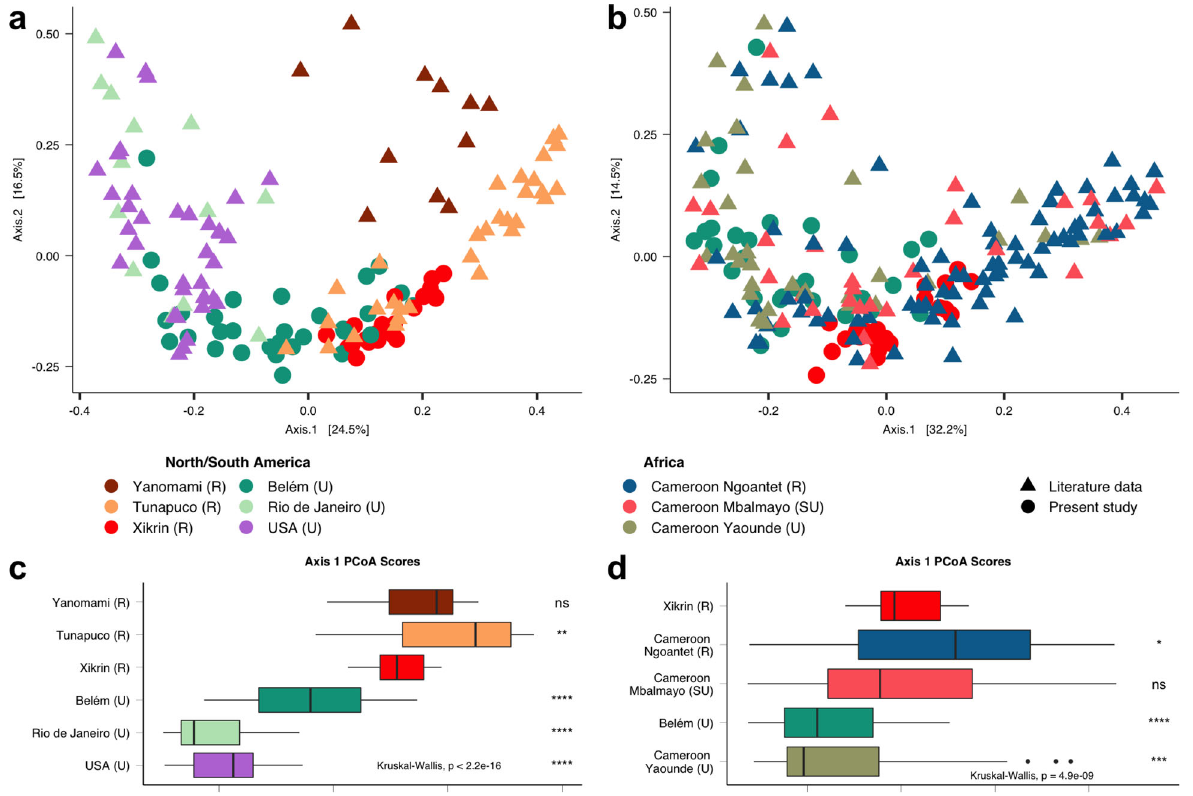
Fig. 5 PCoA of Bray – Curtis distances. a Distances between Amazonian Xikrin (R) and Belém (U) populations to other groups from the American continent. b Distances between Amazonian Xikrin (R) and Belém (U) populations to African groups from an urbanisation gradient in Cameroon. c Boxplots of PCoA scores along axis 1 for the American continent beta-diversity analysis. d Boxplots of PCoA scores along axis 1 for the African urbanisation gradient beta-diversity analysis. NS not signi fi cant, * p ≤ 0.05, ** p ≤ 0.01, *** p ≤ 0.001, **** p ≤